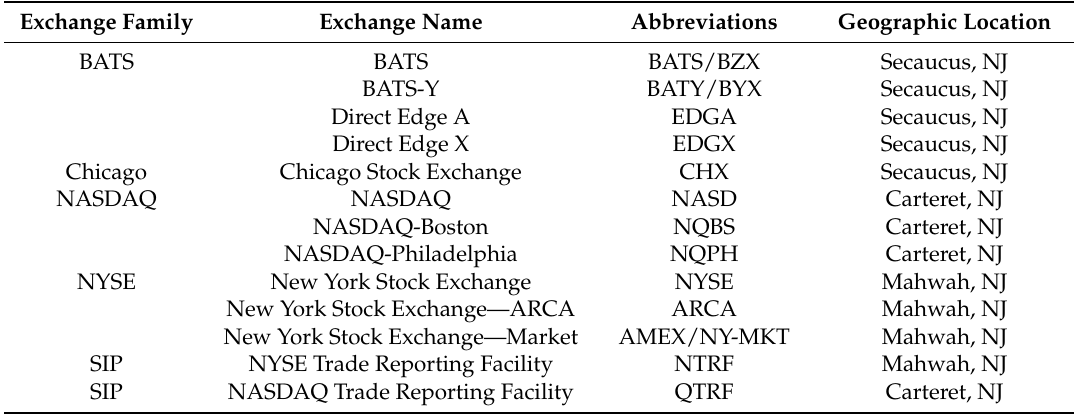
Table A1. Exchanges and Trade Reporting